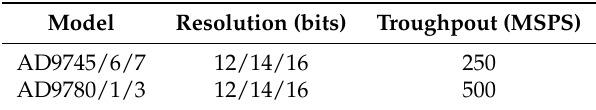
Table 4. Analog Devices DAC converters for a resolution higher than 12 bits and throughput higher than 100